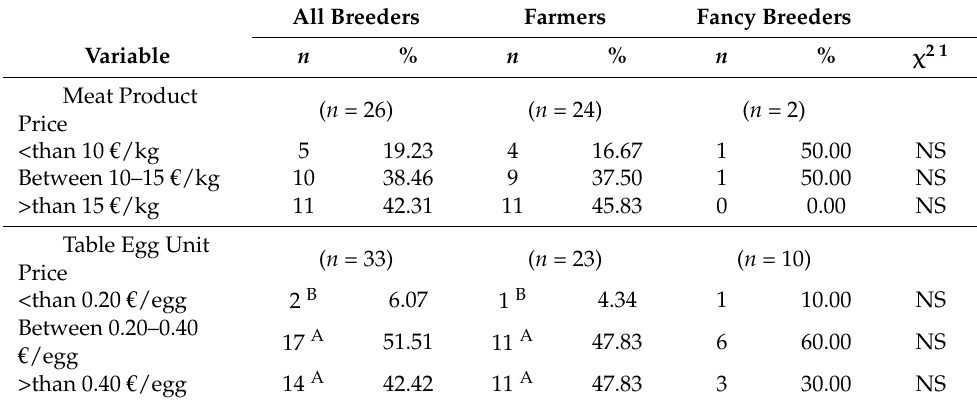
Table 6. Prices of meat products and table eggs obtained from Italian chicken breeds: responses from all breeders and divided according to breeder category. All Breeders Farmers Fancy